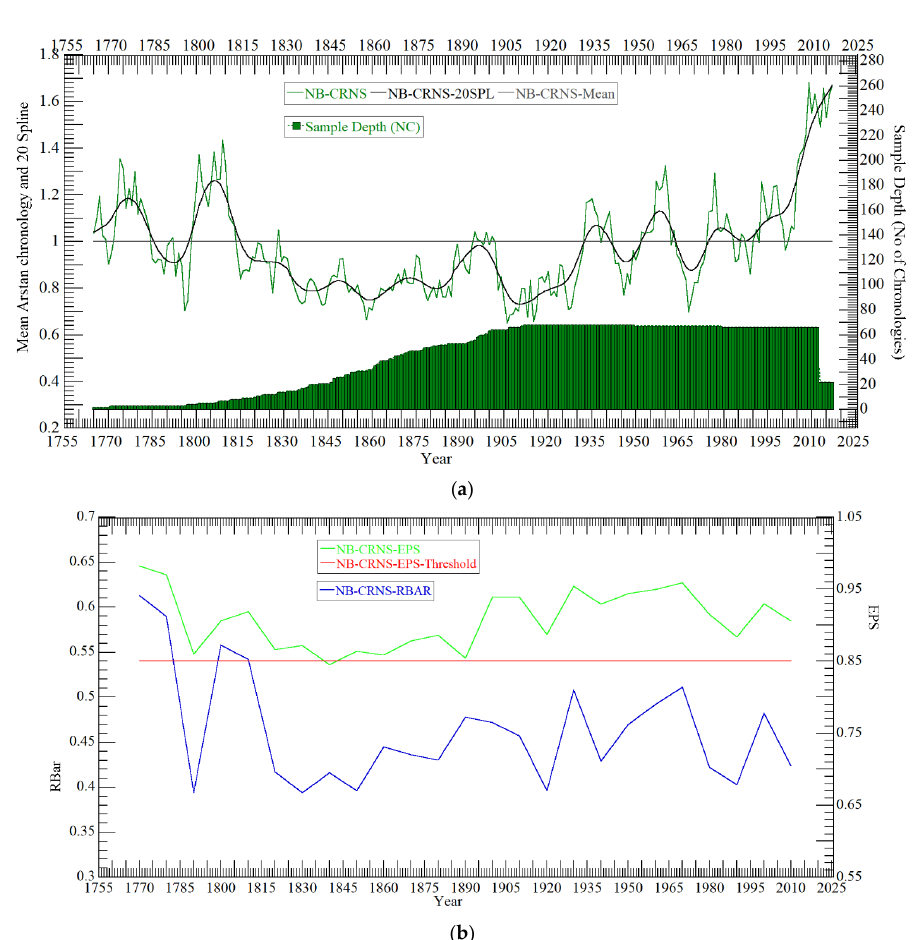
Figure 5. Robust arithmetic mean, sample depth, RBAR, and EPS of composite annual tree-ring width chronology from three sampled treeline regions of Northern Bhutan. ( a ) Robust arithmetic mean composite tree-ring width chronology (NB − CRNS — green line) and sample depth (shaded dark green area) are shown. Black line represents 20-year Low Pass Filtered/smoothed mean composite arstan chronology. ( b ) Running RBAR (blue line) on Y1 axis and Express Population Signals (EPS — green line) on Y2 axis of mean composite arstan chronology from Northern Bhutan (NB-CRNS). Table 1. Statistic metrics of COFECHA and ARSTAN.